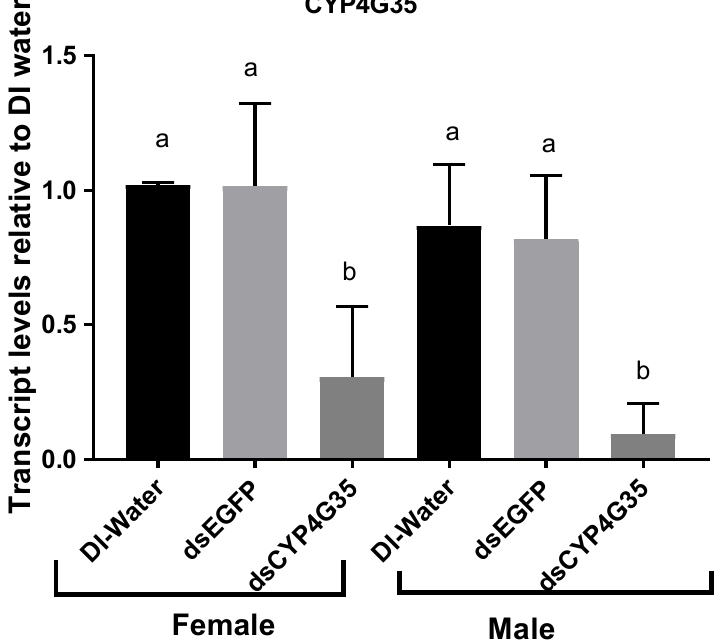
Figure 2. Transcript levels of CYP4G35 in Aedes aegypti adults soaked in dsRNA as pupae. qRT-PCR was used for relative transcript expression and 2 − ∆∆ Ct was used for analysis. Newly molted pupae were soaked in dsRNA or kept in water control until eclosed. Two-day-old adult males and females were collected for RNA extraction. The experiment was replicated three times with different biological cohorts of mosquitoes. N = 9. Mean ± SD. The letters above bars show statistical differences among samples. Four additional genes: CYP4G36 (XM_001648326.2), insulin-like peptide 5 (ILP5; DQ845758.1/XM_001662872.2), ILP6 (DQ845755), and ILP7